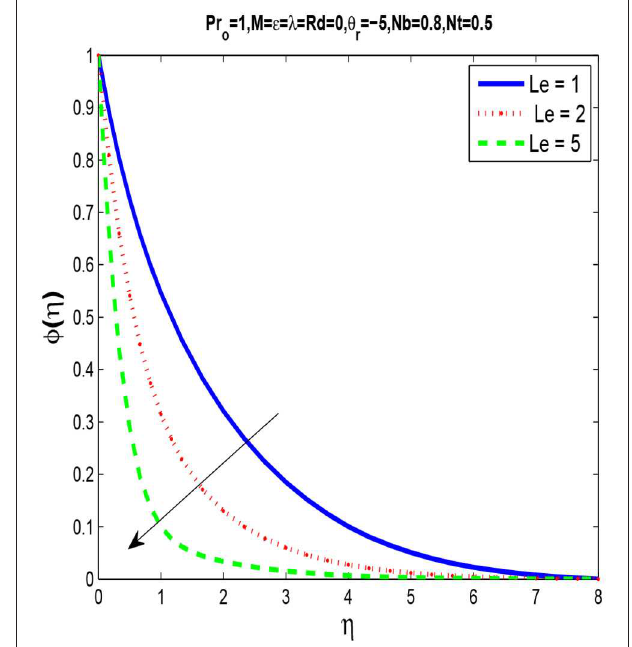
FIGURE 9 | Temperature profile θ ( η ) for different Pr o ( For Case B).